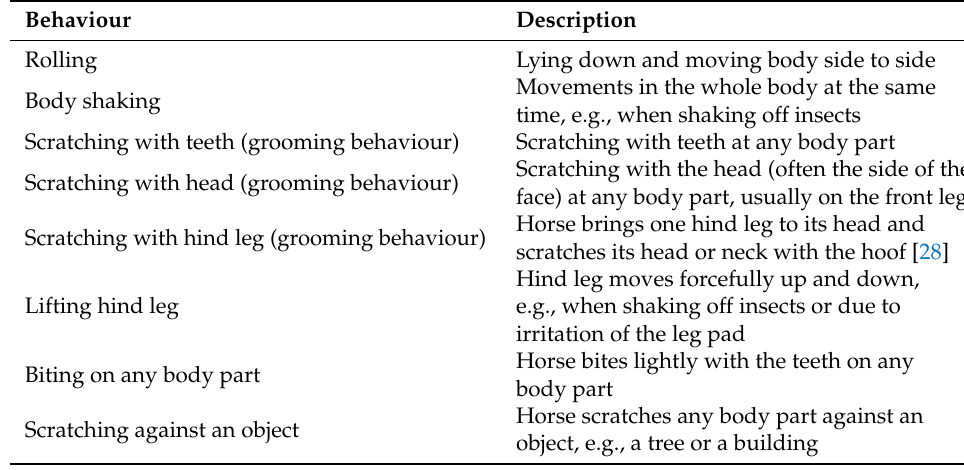
Table 3. Ethogram used in behaviour